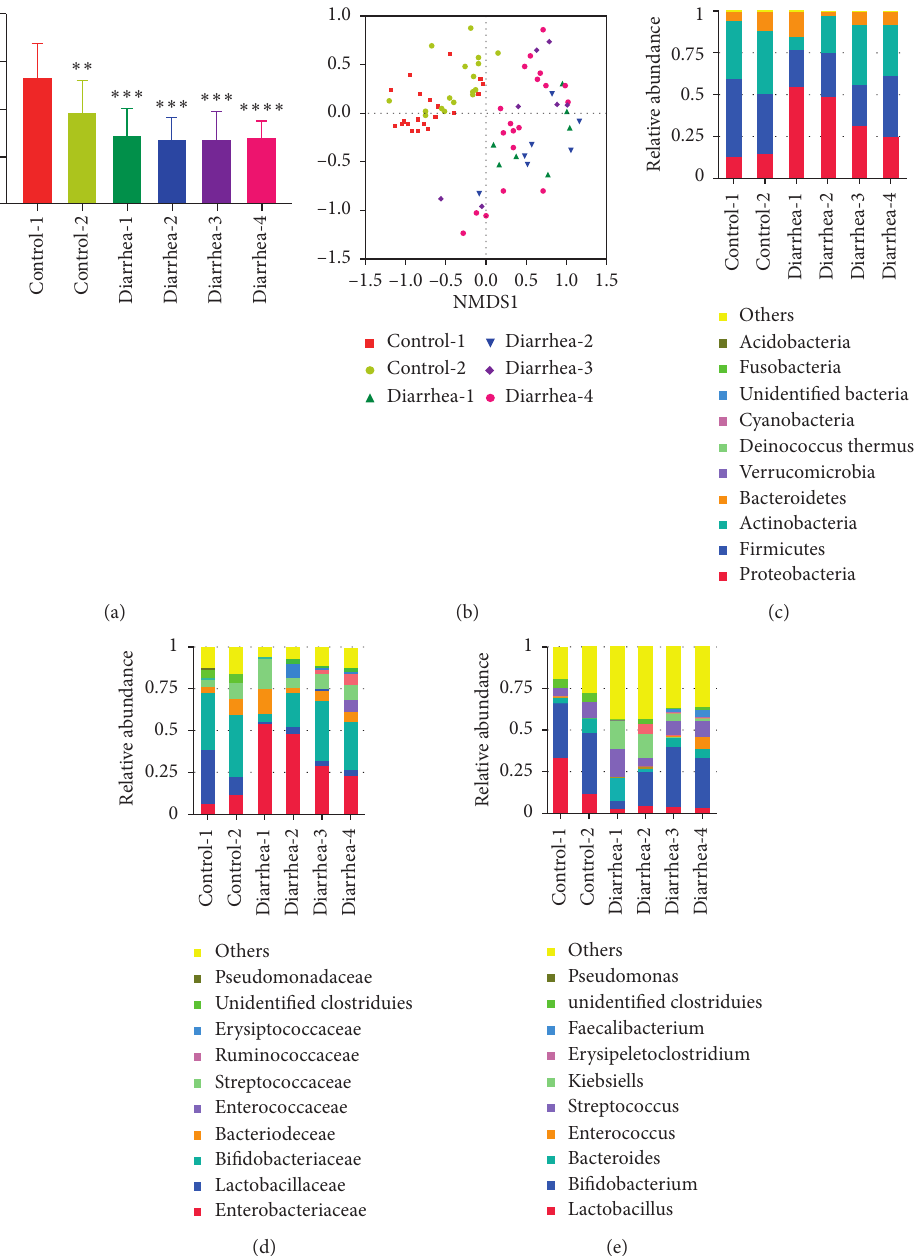
Figure 5: The gut microbiota of healthy infants and infants with diarrhea of different ages. (a). The comparison of the alpha diversity (ACE index) of various ages based on the OTUs profiles. (b). The NMDS of beta diversity is calculated on ranking order. The relative abundance of the top 10 microbiota at the phylum (c), order (d), and genus level (e). Control-1: 0–120-day-old healthy infants; control-2:120–180-day-old healthy infants; diarrhea-1: 0–120-day-old diarrheic infants; diarrhea-2: 120–180-day-old diarrheic infants; diarrhea-3: 180–270-day-old diarrheic infants; diarrhea-4: 270–360-day-old diarrheic